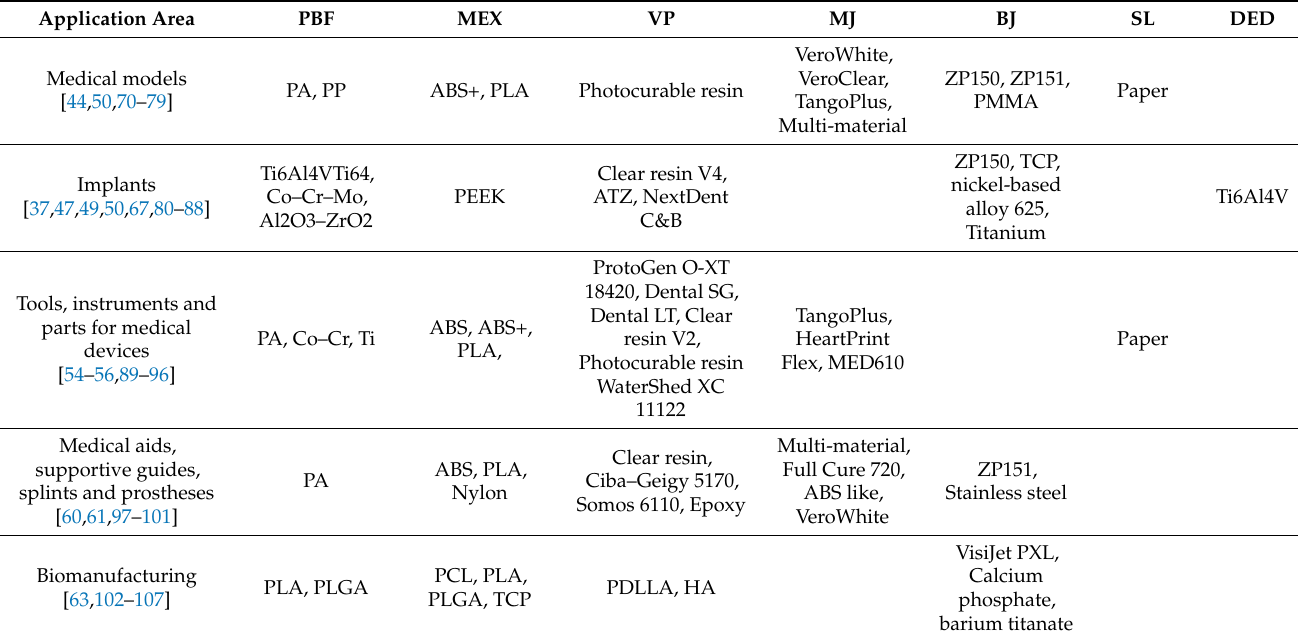
Table 4. Different AM processes in medical